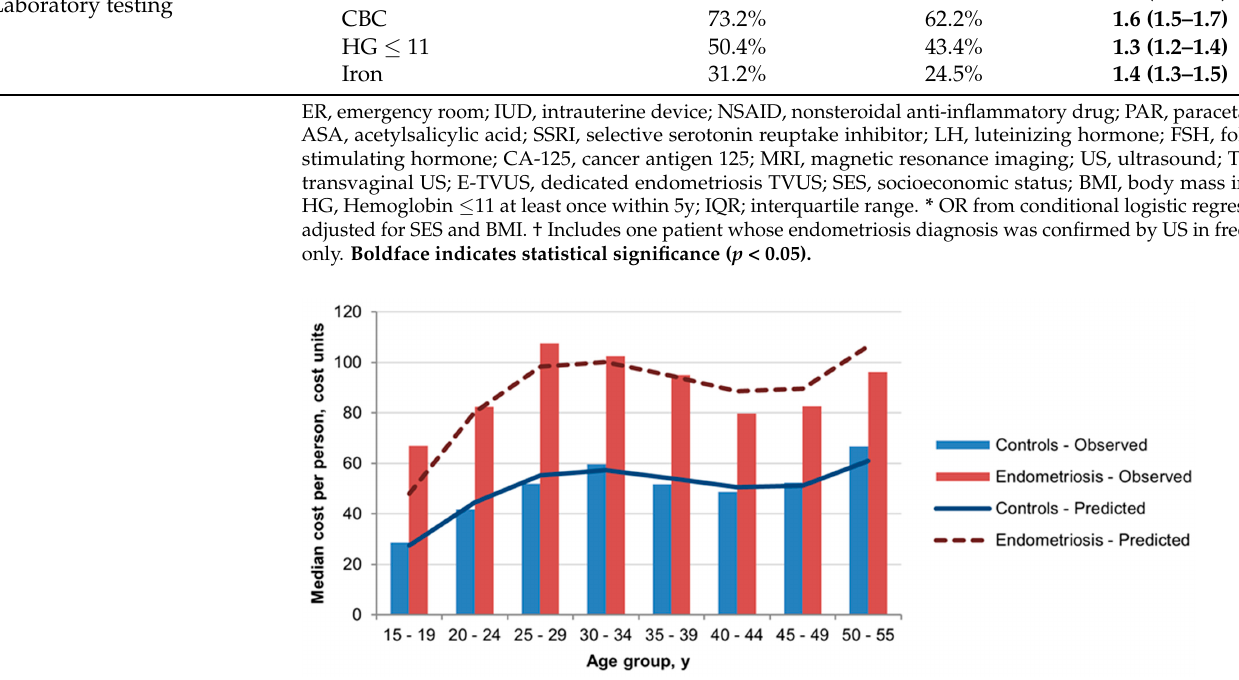
Figure 2. Observed and predicted median costs per person (endometriosis vs. controls) based on total annual direct medical costs in the local healthcare service and estimates from the generalized linear model adjusted for age.